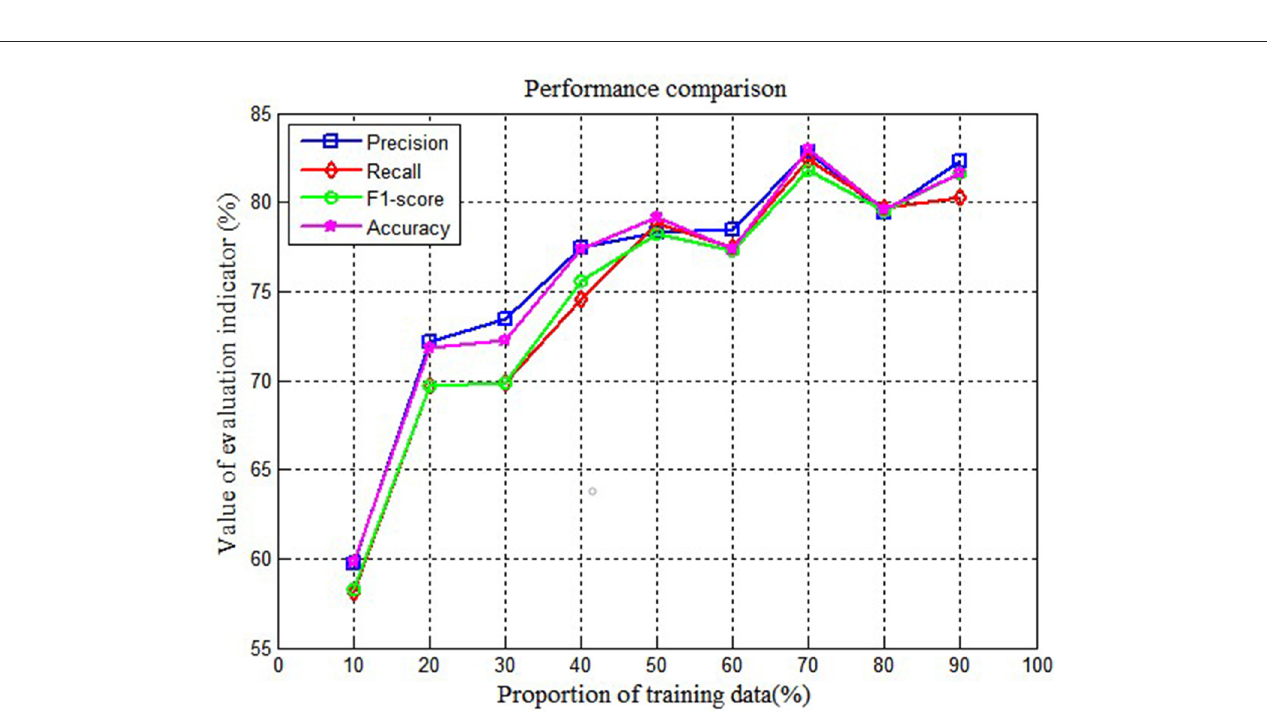
FIGURE6 Performance comparison on different proportions of training